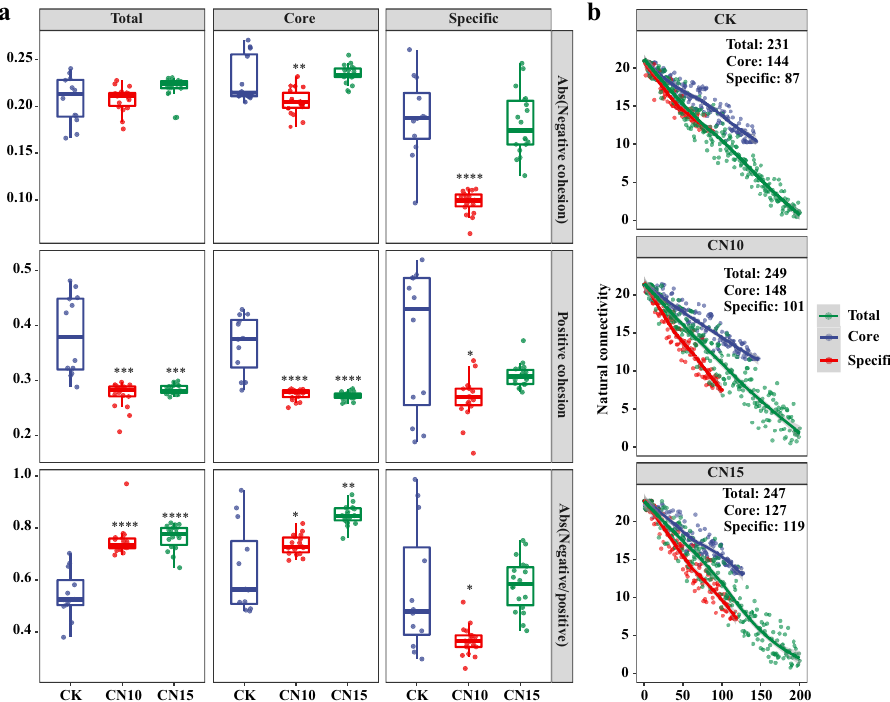
Fig. 4 Effects of sucrose addition on the bacterial network properties of the culture systems. a Changes in absolute value of negative cohesion, positive cohesion, and absolute value of negative:positive cohesion ratio of total, core and speci fi c bacterial communities in CK ( n = 12), CN10 ( n = 18), and CN15 ( n = 18) groups. The boxes represent the median and interquartile range, and whiskers range from minimum to maximum values. Different asterisks indicate a signi fi cant difference at * p < 0.05, ** p < 0.01, *** p < 0.001 and **** p < 0.0001 based on Student ’ s t test. b Changes in robustness (natural connectivity) of total, core and speci fi c bacterial networks in CK ( n = 12), CN10 ( n = 18) and CN15 ( n = 18) groups. CK: without sucrose addition; CN10: the C/N ratio of about 10:1 obtained by sucrose addition; CN15: the C/N ratio of about 15:1 obtained by sucrose